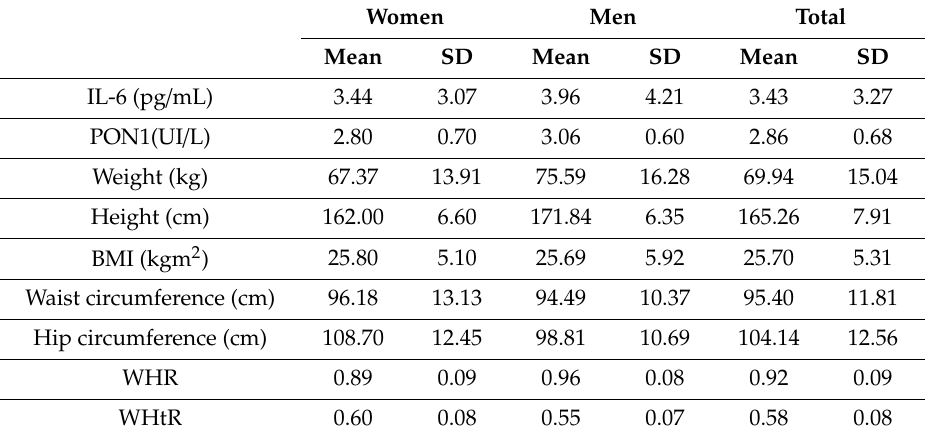
Table 1. Biochemical and anthropometric values analysed in the population sample.